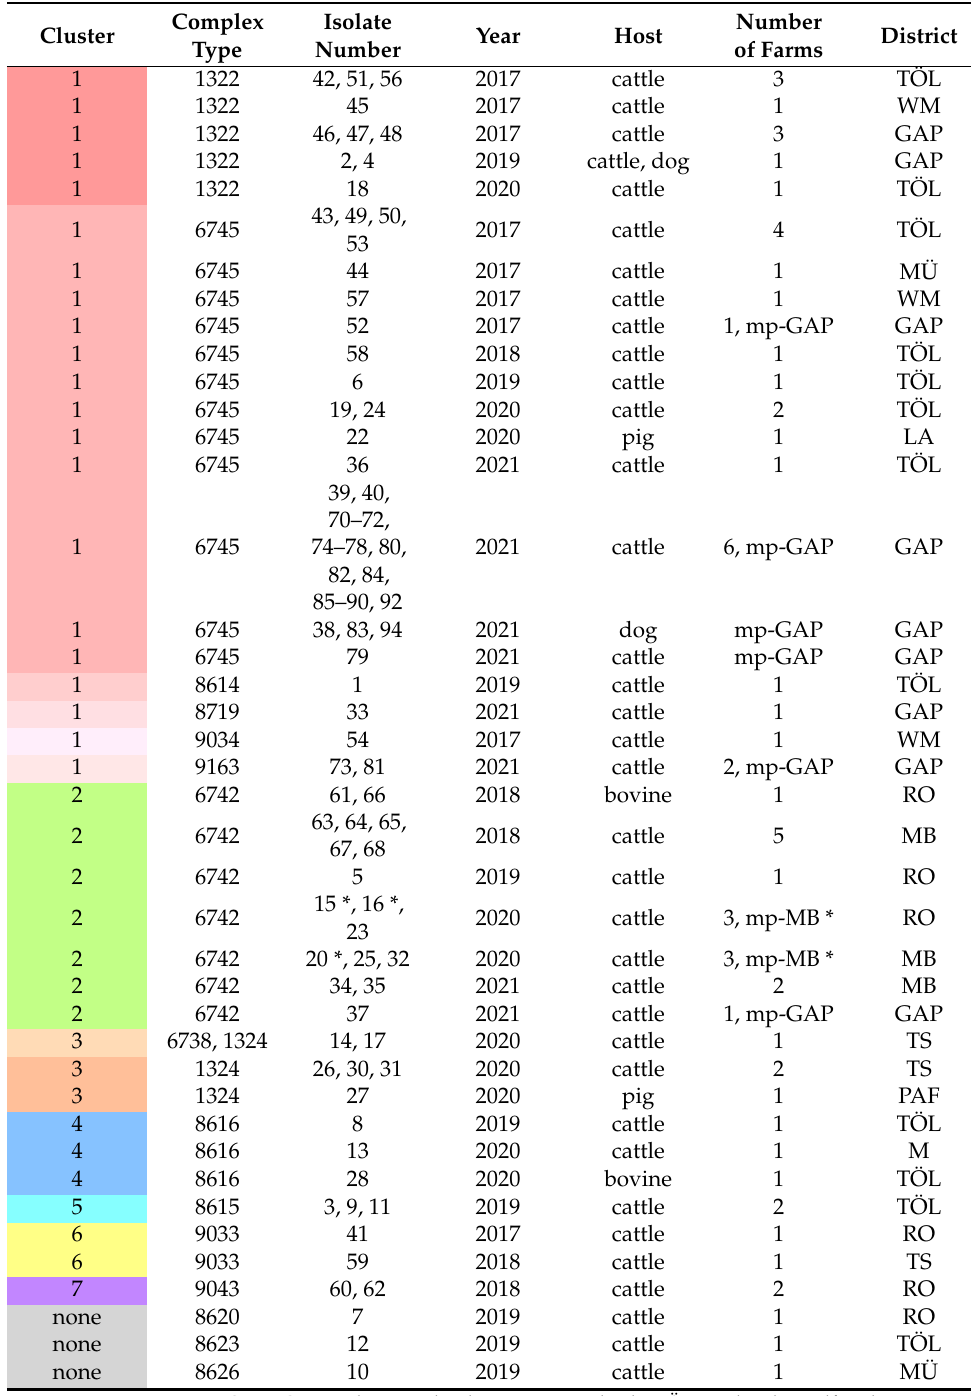
Table 1. Metadata and cgMLST results for 88 S. Dublin isolates (2017–2021) from 54 animal disease outbreaks were investigated in this study (compare Table